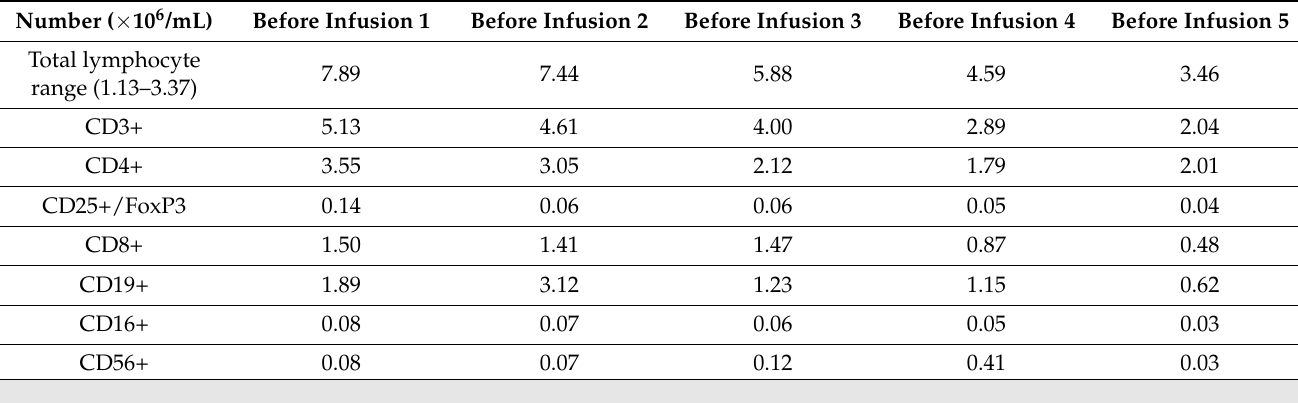
Table 4. Cell subsets expressed as number of cells × 10 6 /mL. In vitro T cell proliferation to PHA is expressed as stimulation index (SI) = cpm stimulated/cpm